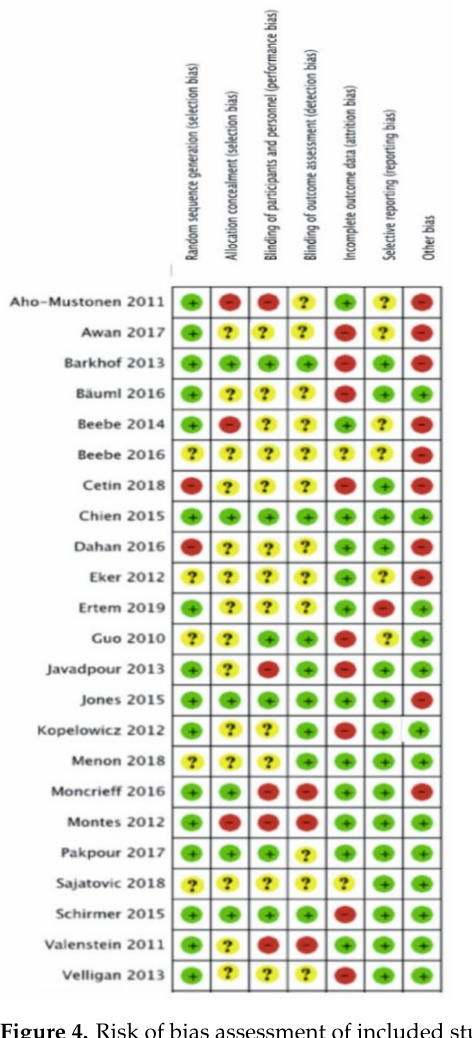
Figure 4. Risk of bias assessment of included studies using the Cochrane Risk of bias